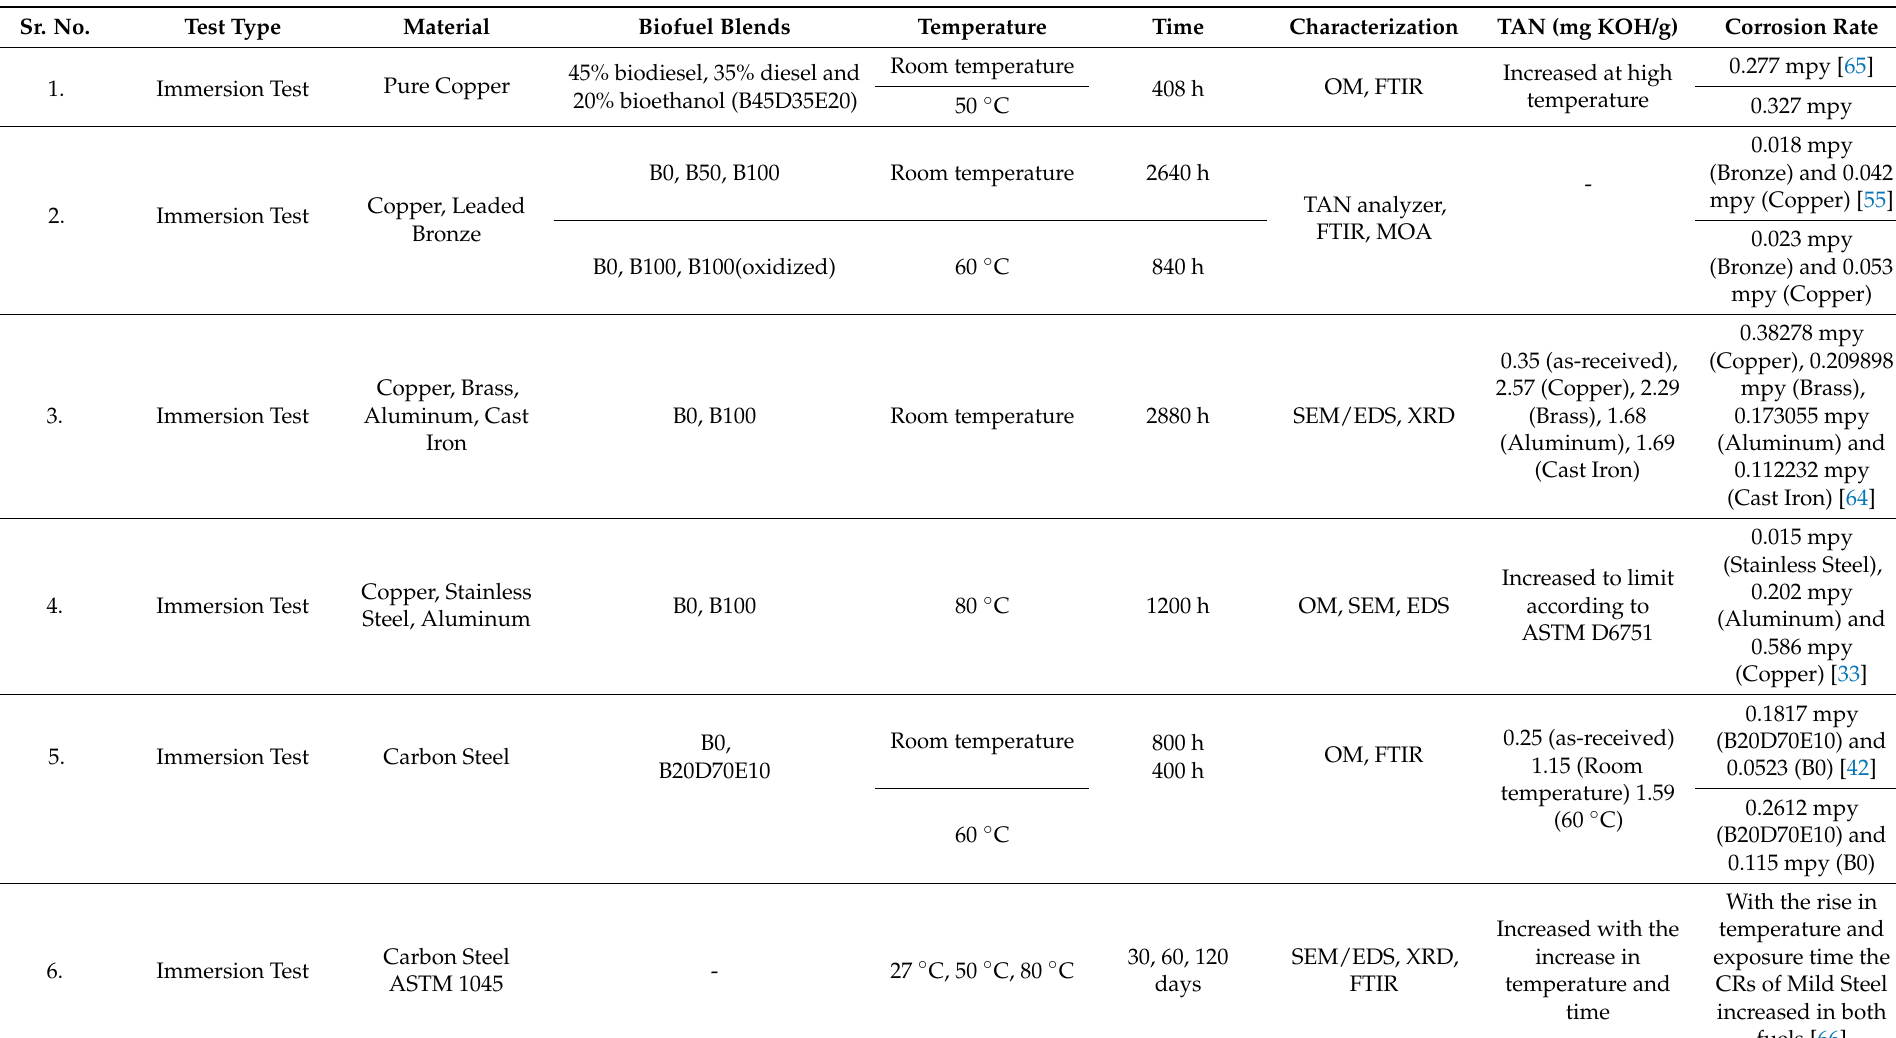
Table 1. Summary of corrosion studies using palm oil-based